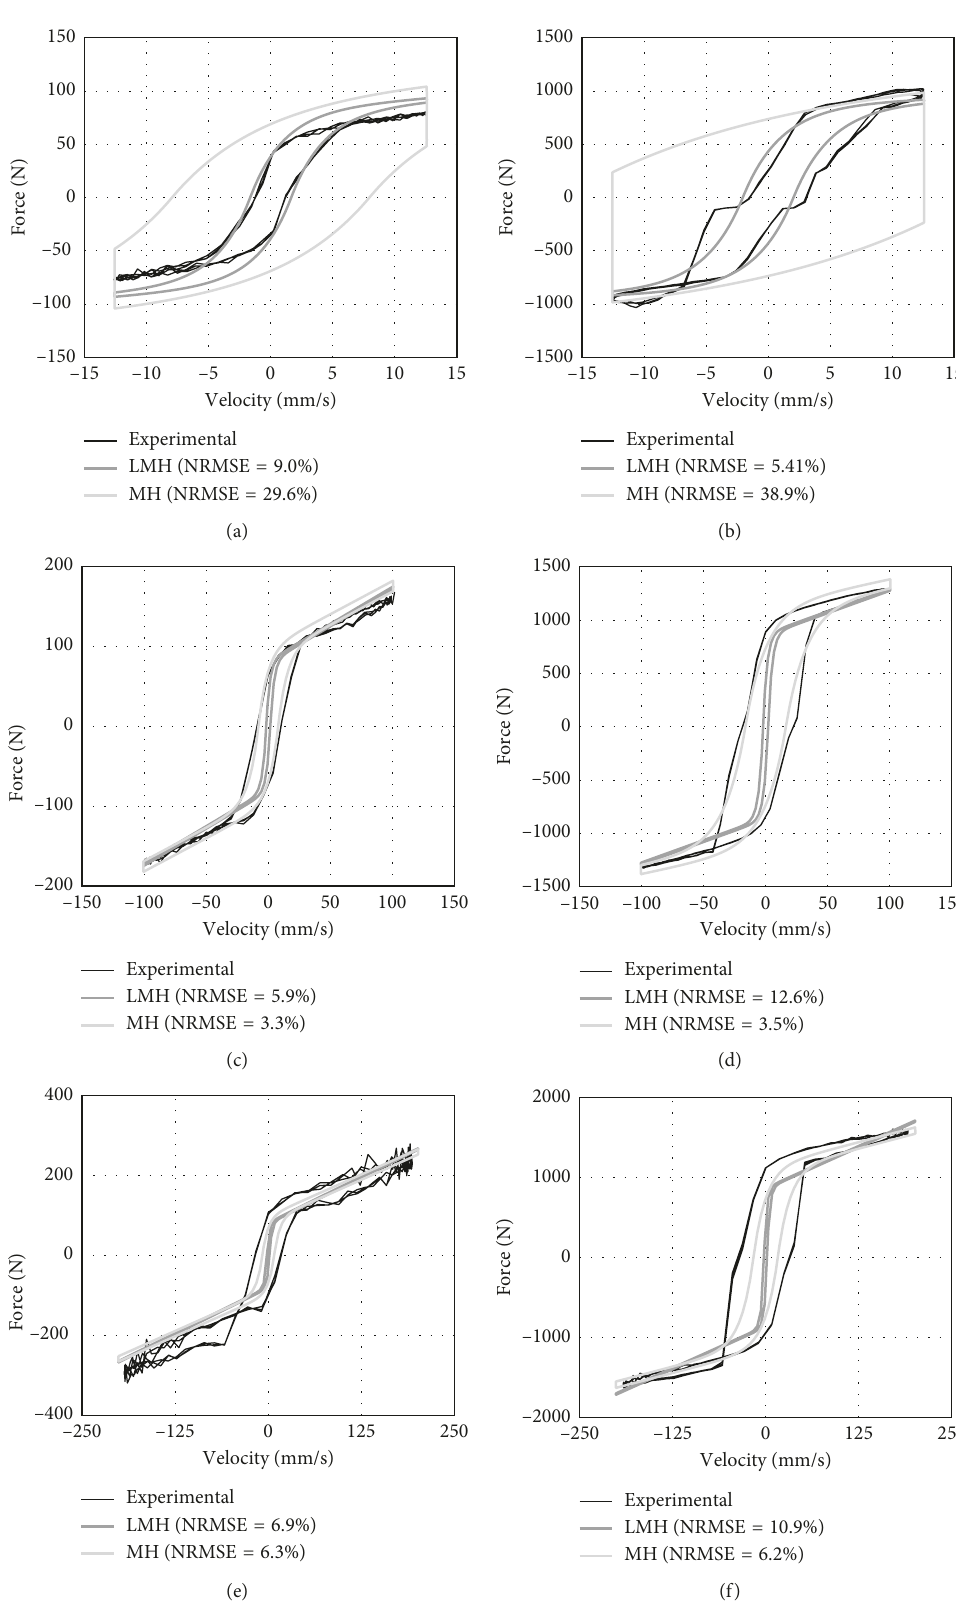
1A; (e) high velocity without (cid:31)